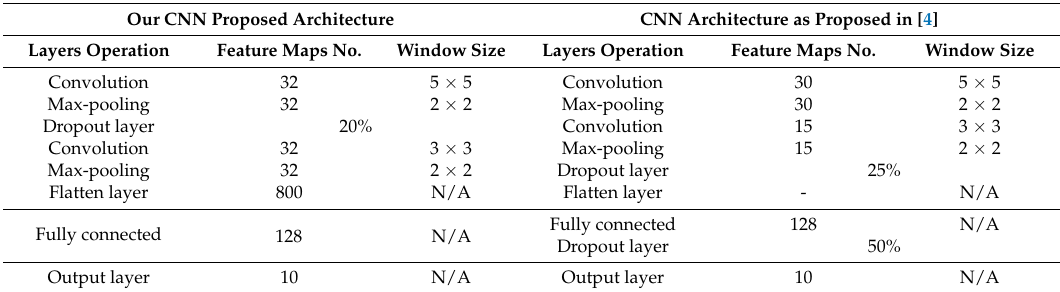
Table 6. Our CNN proposed architecture compare with CNN architecture proposed in [4].